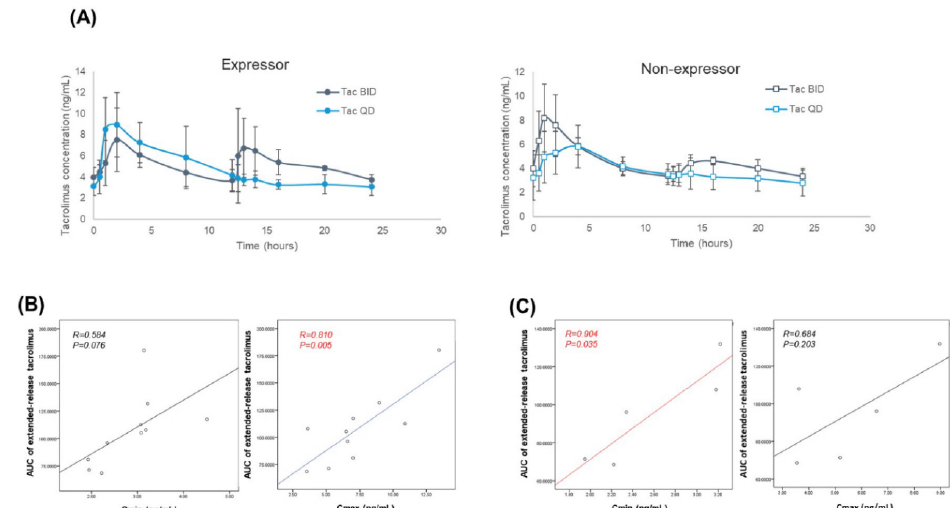
Figure 4. ( A ) 24-h arithmetic mean whole blood tacrolimus concentrations (ng / mL) and standard deviation for the twice-daily and once-daily formulations; ( B ) Correlation between the area under the curve (AUC) and Cmin or Cmax in the expressor group after conversion to once-daily extended-release tacrolimus; ( C ) Correlation between the area under the curve (AUC) and Cmin or Cmax in the non-expressor group after conversion to once-daily extended-release tacrolimus.